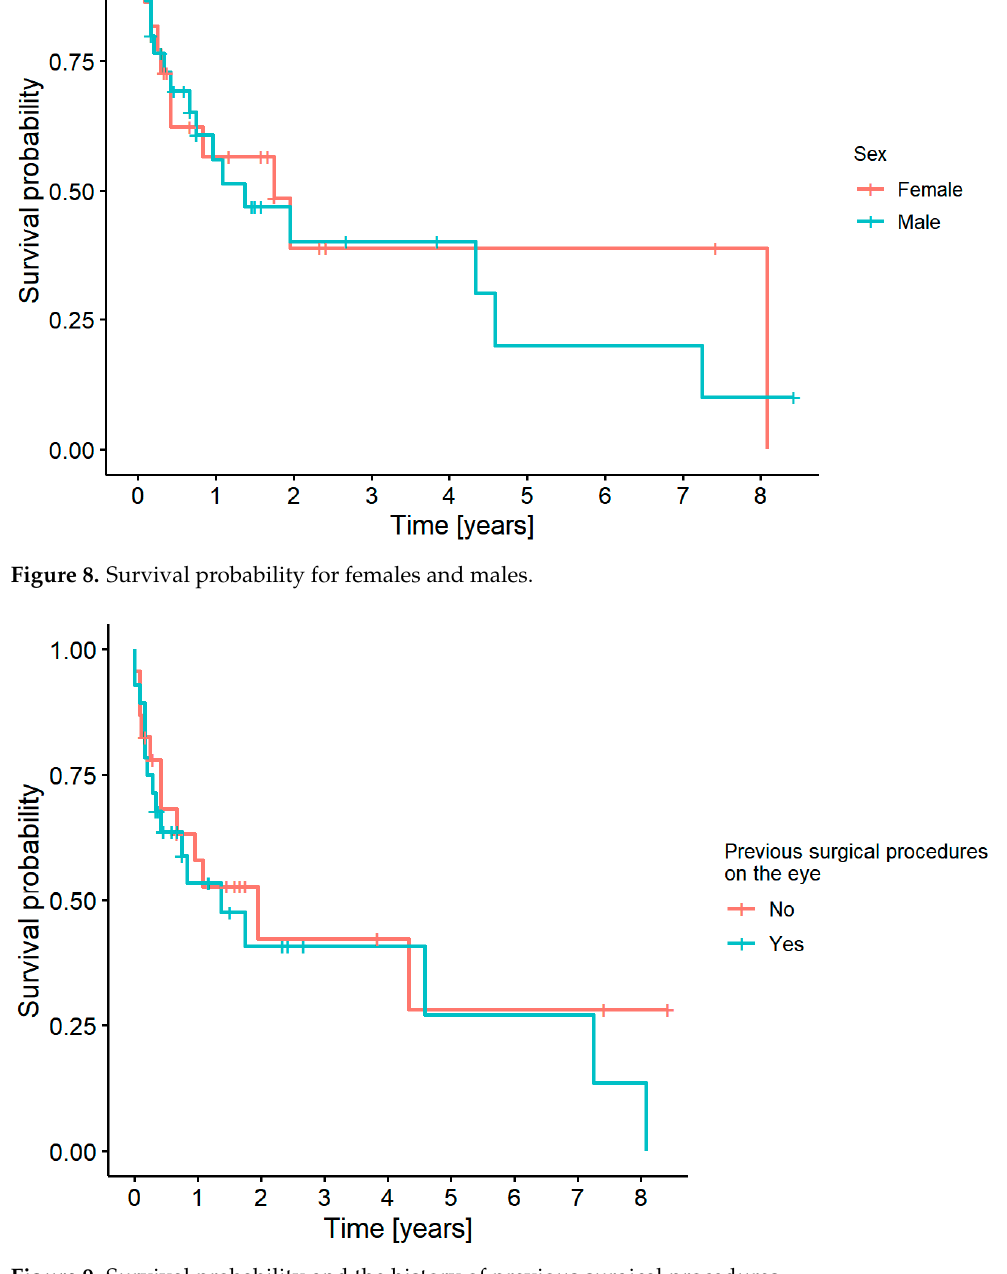
Figure 9. Survival probability and the history of previous surgical procedures.